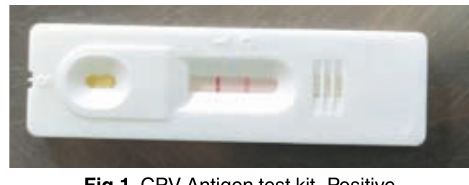
Fig.1. CPV Antigen test kit- Positive